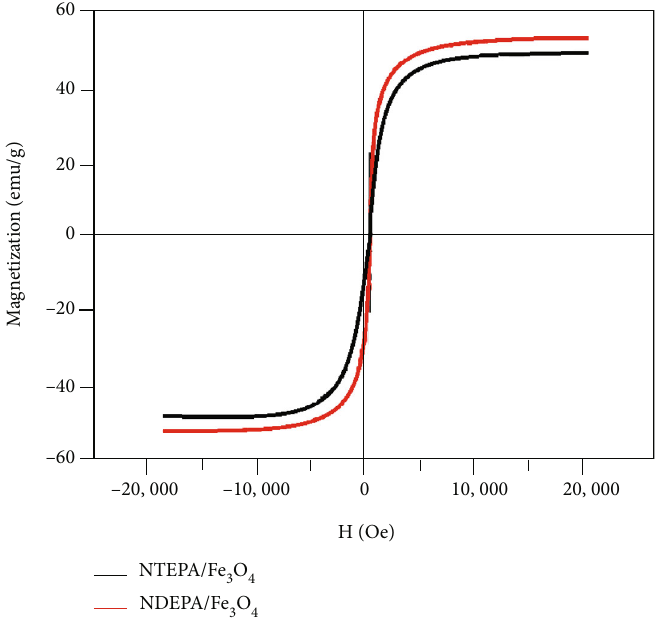
Figure 9: VSM loop of NTEPA/Fe